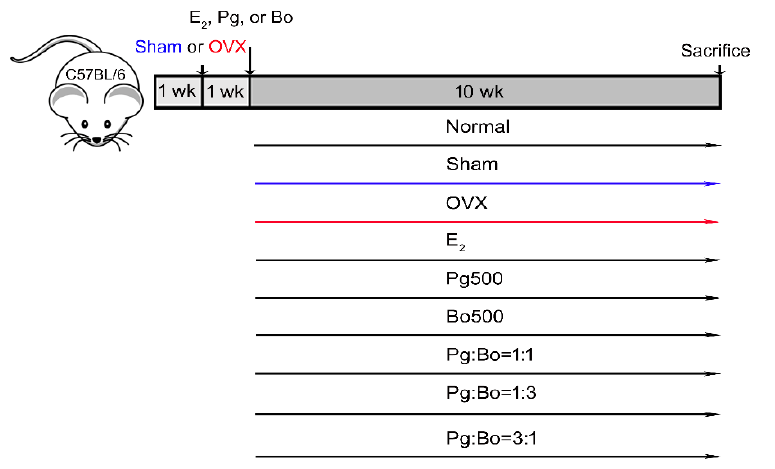
Figure 3. Effect of Pg and Bo on bone weight and bone mineral density. ( A ) Bone weight was measured on the day of sacrifice ( n = 10). Bone mineral content (BMC) ( B ) and bone mineral density (BMD) ( C ) of right femurs were measured using a DXA ( n = 8). All values are expressed as mean ± SEM. * p < 0.05 and ** p < 0.01 compared with Sham, # p < 0.05 and ## p < 0.01 compared with OVX.